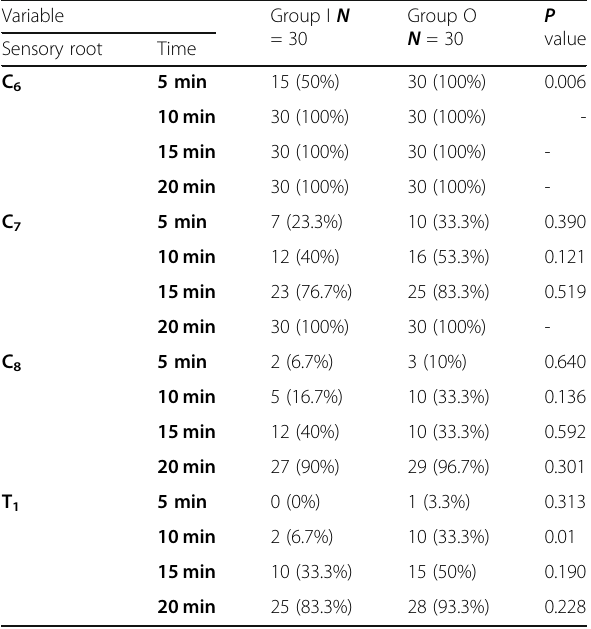
Table 4 Progression of the sensory block over the first 20 min